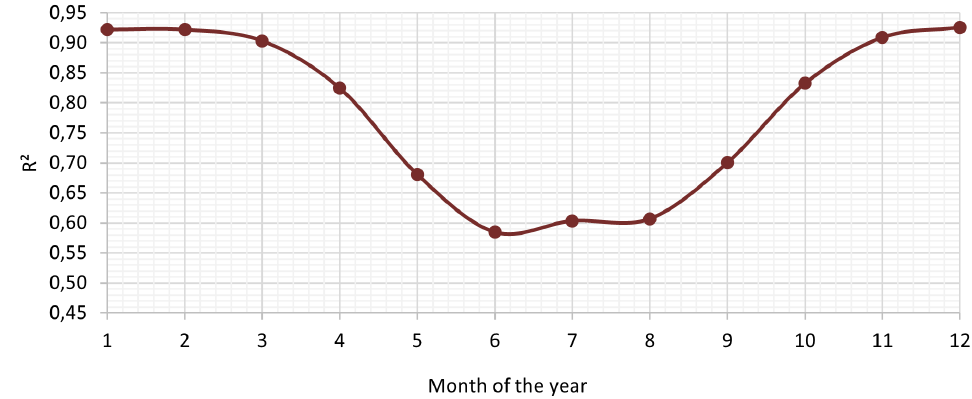
Figure 5. Coefficient of determination of the ANOVAs over one